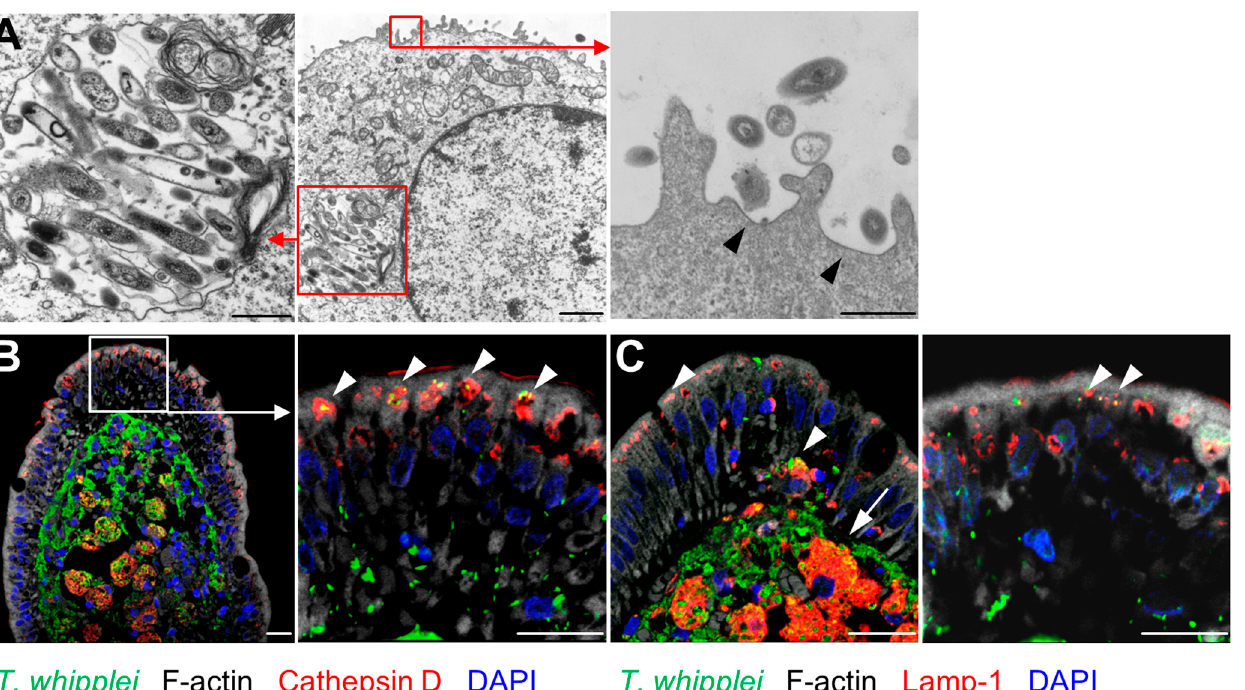
Figure 3. Compartments involved in T. whipplei endocytosis. ( A ): T84 cell after apical uptake of TW analyzed by transmission electron microscopy. Large vesicles containing numerous intact TW rods (left panel). Formation of TW -containing vesicles with apical membrane condensation and protrusions (right panel, arrowhead). Size bars, middle panel: 1 µ m; left and right panel: 500 nm. ( B , C ): Compartments involved in TW endocytosis in untreated WD patients. Details of the epithelial layer are shown in the right panels. ( B ): Immunofluorescence staining of TW (green), cathepsin D (red), F-actin (white), and nuclei (blue). TW is located in an apical lysosomal compartment (red, cathepsin D) within the epithelium (arrowhead). ( C ): TW is located in an intraepithelial late endosomal compartment (Lamp-1, red; arrowhead) and within lamina propria macrophages (arrow). Size bars, 20 µm.